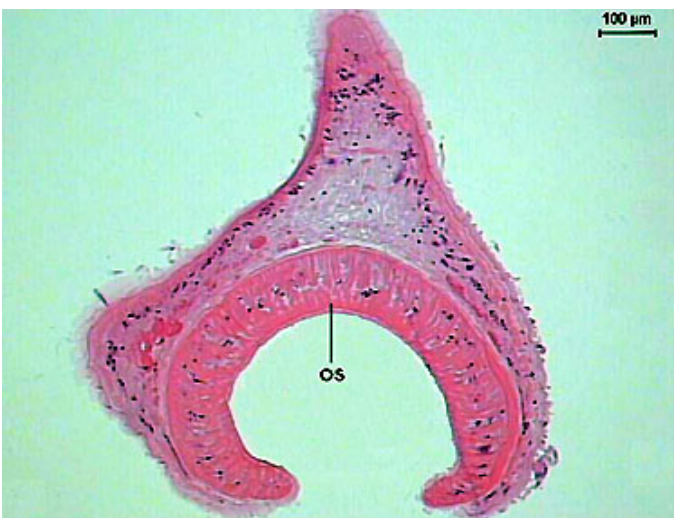
Figure 4. Transversal section of Sticholecitha serpentis . OS - oral sucker. HE.